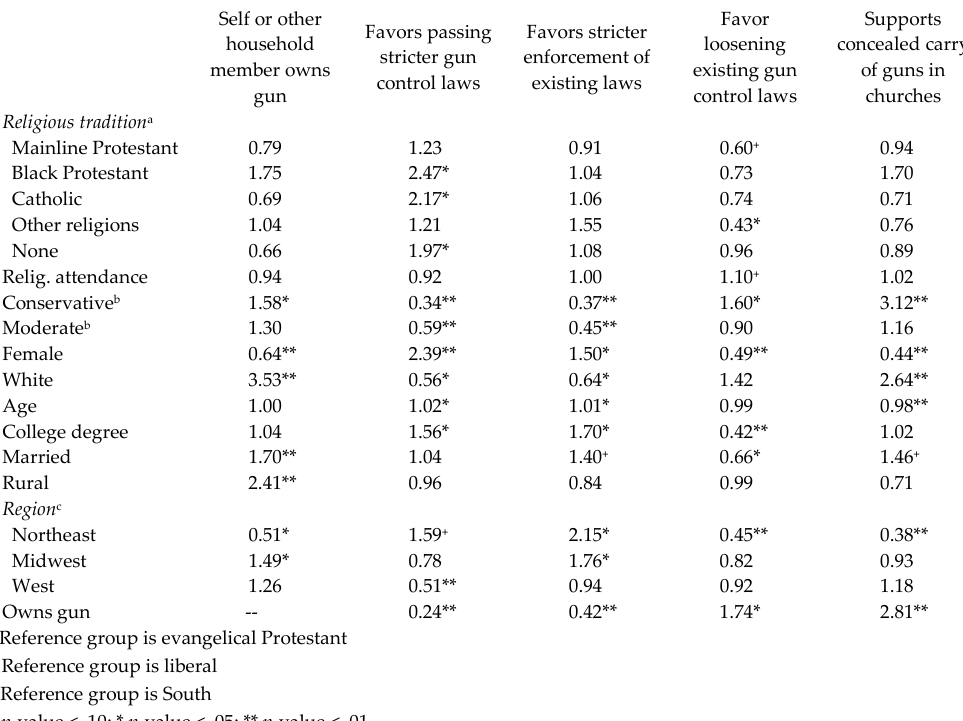
Table 4. Estimated odds ratios predicting gun ownership and support for gun control.